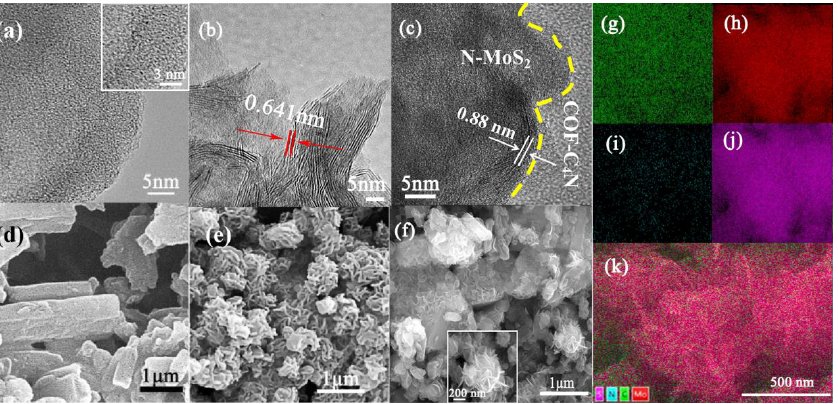
Figure 3. TEM images of ( a ) COF-C 4 N, ( b ) N-MoS 2 , ( c ) N-MoS 2 /COF-C 4 N; SEM images of ( d ) COF- C 4 N, ( e ) N-MoS 2 , ( f ) vertical N-MoS 2 /COF-C 4 N. STEM-EDS mapping of vertical N-MoS 2 /COF-C 4 N with ( g ) Mo, ( h ) N, ( i ) C, ( j ) S, ( k ) EDS layered image .